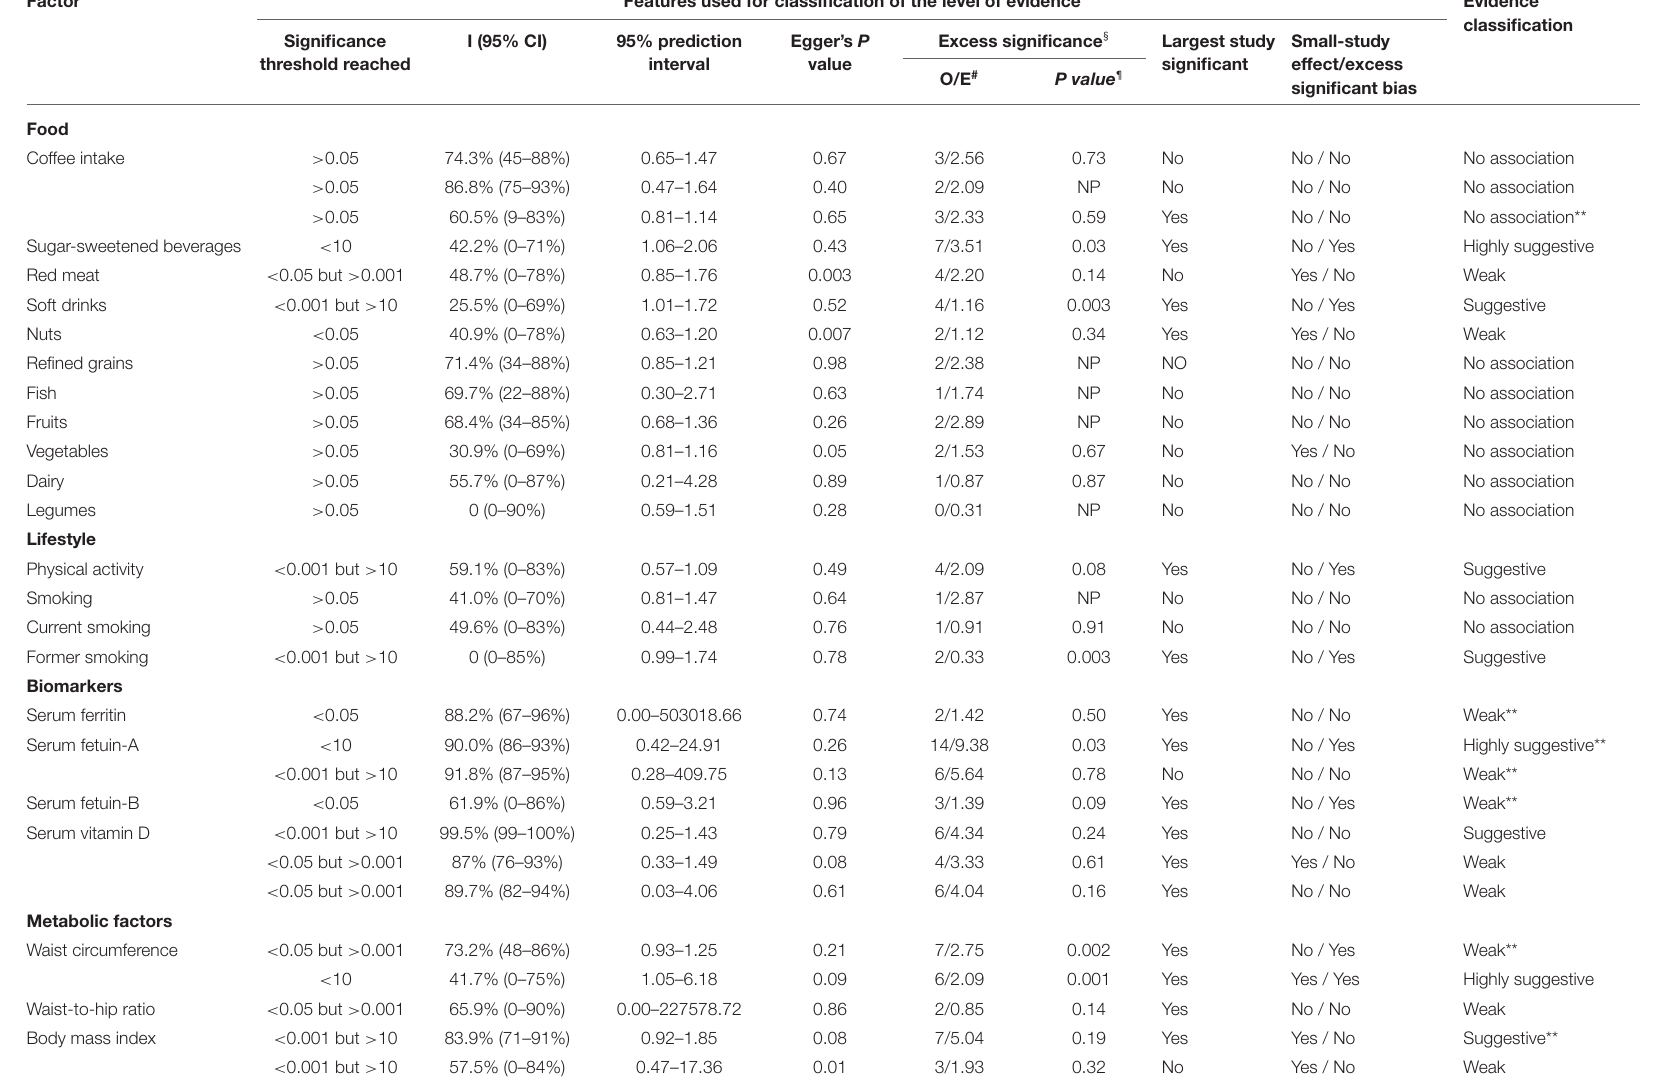
TABLE 2 | Levels of evidence for the association of risk factors for